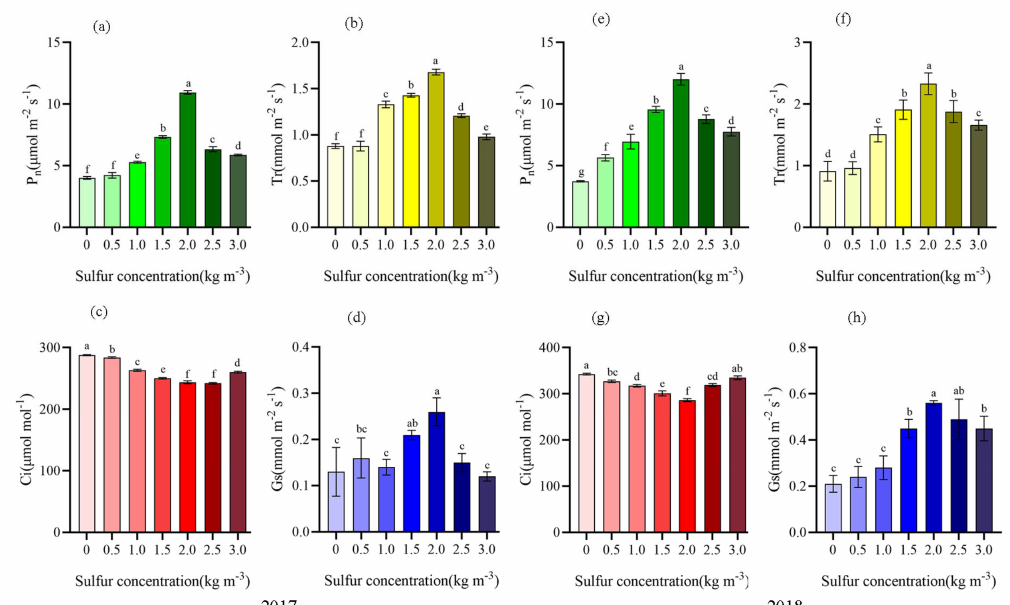
Figure 2. Effects of sulfur on photosynthetic characteristics of kiwifruit leaves. Different letters indicate significant difference between means at p < 0.05. Value are means ± SE (n = 3). Abbreviations: Pn, net photosynthesis rate; Tr, transpiration rate; Gs, stomatal conductance; and C i , intercellular CO 2 concentration. ( a ) Net photosynthesis of kiwifruit leaves in 2017; ( b ) Transpiration rate of kiwifruit leaves in 2017; ( c ) Intercellular CO 2 concentration of kiwifruit leaves in 2017; ( d ) Stomatal conductance of kiwifruit leaves in 2017; ( e ) Net photosynthesis of kiwifruit leaves in 2018; ( f ) Net photosynthesis of kiwifruit leaves in 2018; ( g ) Intercellular CO 2 concentration of kiwifruit leaves in 2018; ( h ) Stomatal conductance of kiwifruit leaves in 2018.